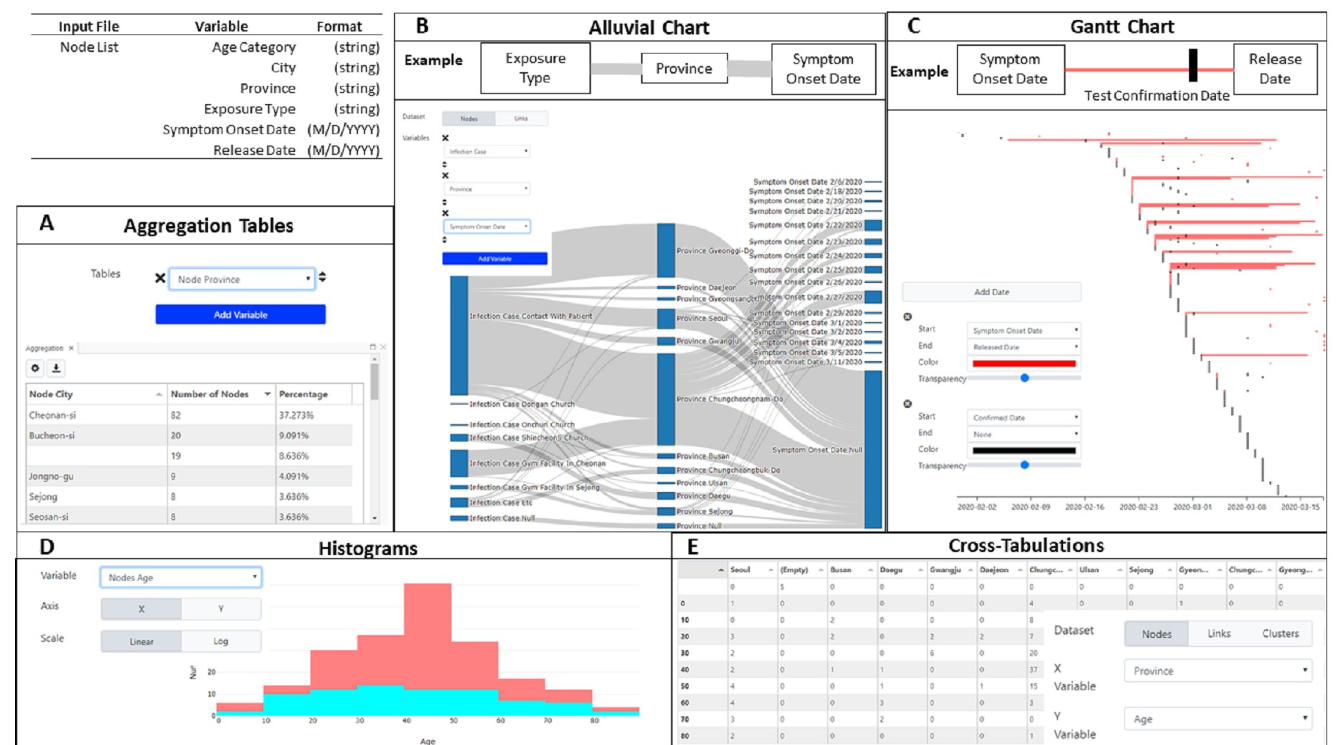
Fig 4. MicrobeTrace visualization does not require genomic or contact tracing data and can easily calculate aggregation and cross-tabulation tables in addition to visualizing histograms, alluvial/flow diagrams and Gantt charts. Each diagram has an inset settings menu that describes the settings changes necessary to achieve them. (4A) City-level aggregation achieved via a single dropdown selection. (4B) Alluvial diagram of associations between the Type of Exposure to COVID-19, Province, and Symptom Onset Date. (4C) Gantt charts to describe the span of time between Symptom Onset, Positive Test Confirmation, and Hospital Release Date. (4D) Age histogram, binned by decade and colored by gender. This histogram illustrates a trend identified early in the Korean COVID-19 outbreak, wherein a disproportionate number of middle-age female cases were diagnosed (4E) Cross-tabulation table of cases by City and Age categories.